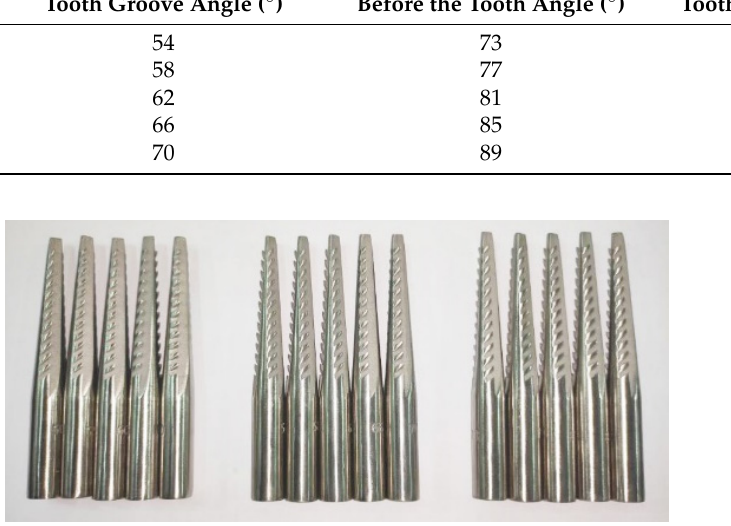
Figure 10. Samples of used spindles in the test. Table 1. The tooth angle factors of the spindle